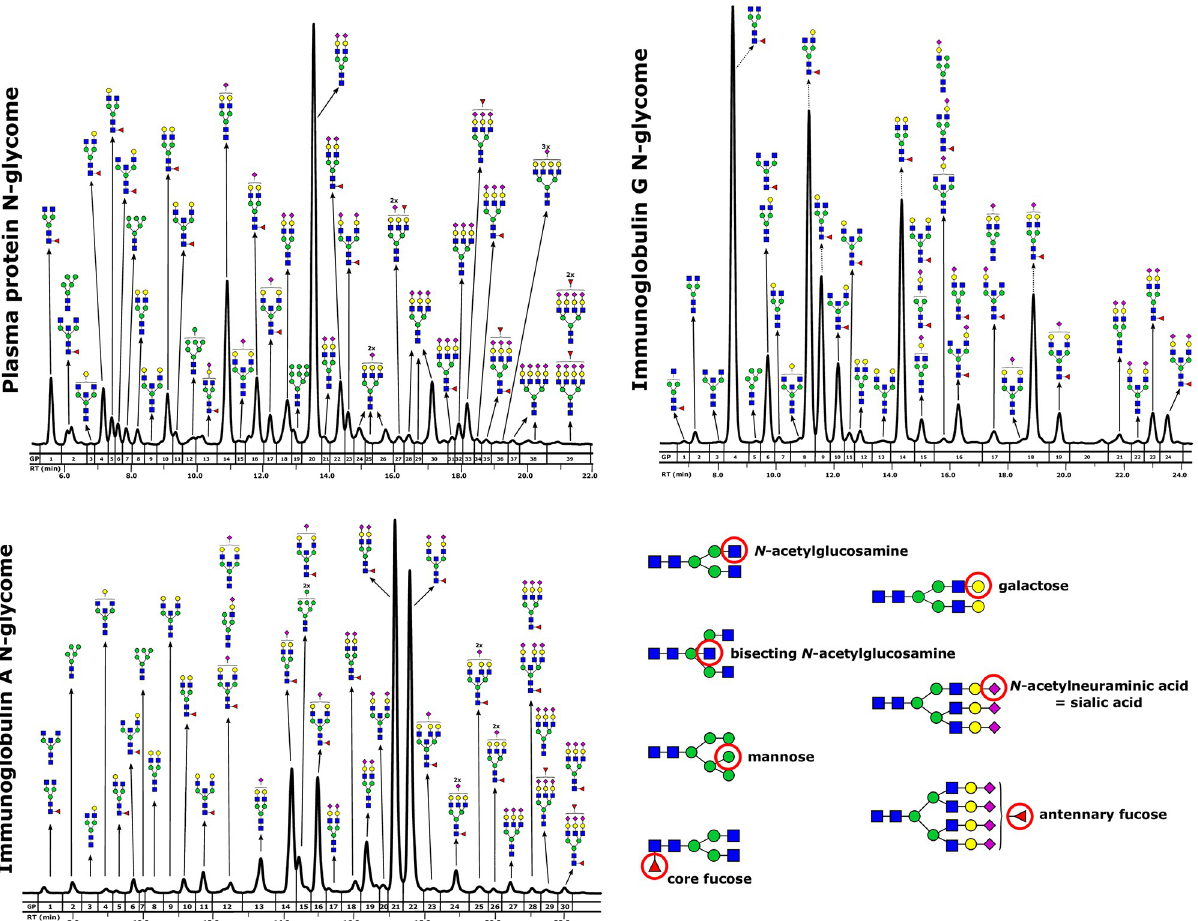
Fig 1. Representative HILIC-UPLC-FLR chromatograms of plasma protein, immunoglobulin G and immunoglobulin A N-glycomes, with graphic representation of the most abundant glycan structure corresponding to each glycan peak (GP).